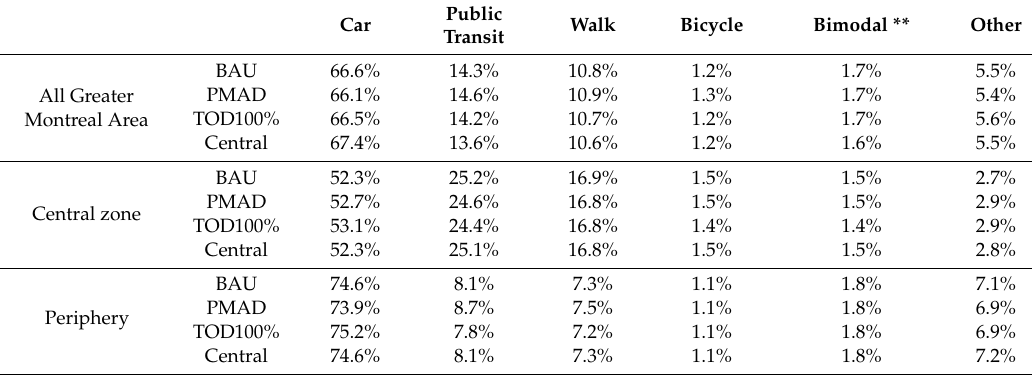
Table A1. Modal share for each 2031 scenario, according to mode choice analyses, for the entire Greater Montreal Area, the “central zone” and the periphery (trips unweighted) *.